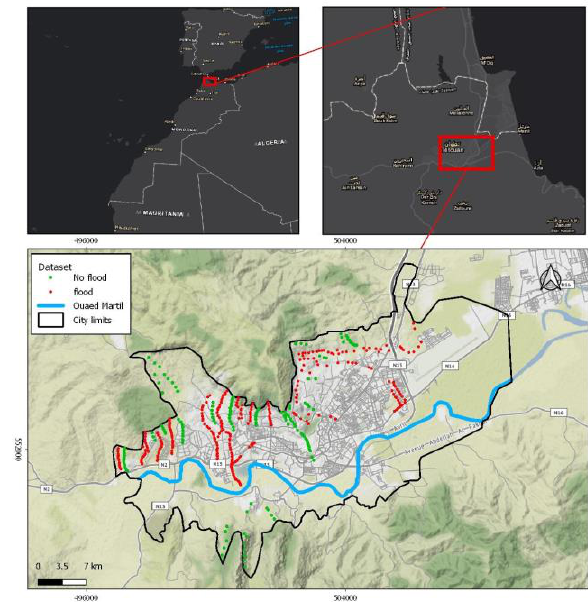
Figure 1 : Geographical location of the study area